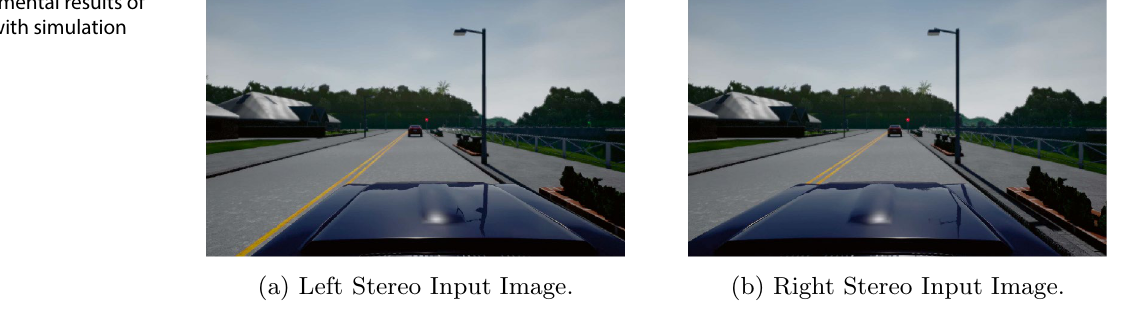
Fig. 14 Experimental results of stereo vision with simulation